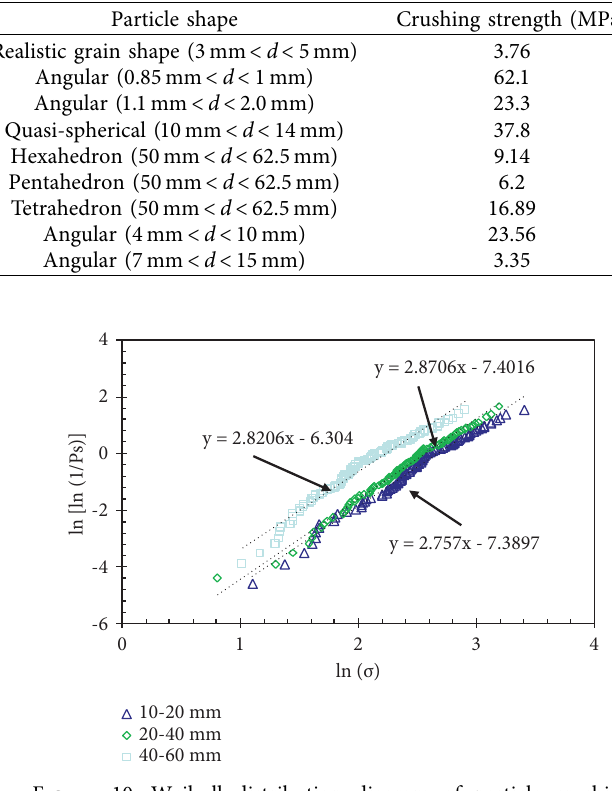
Table 3: Test results of diferent particle materials.